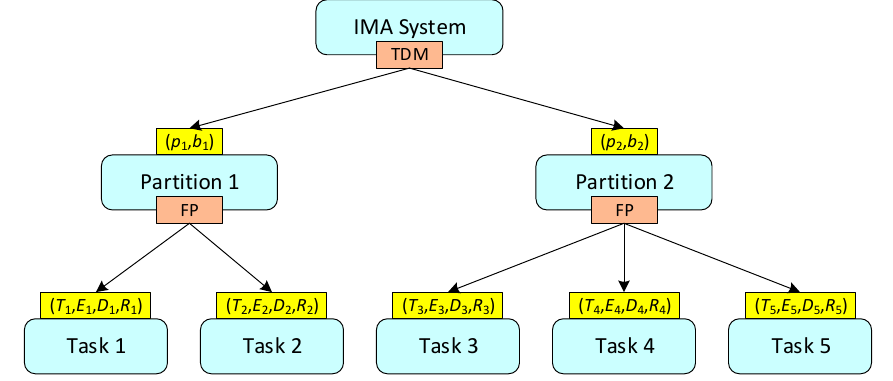
Figure 1. An example of partition scheduling systems of integrated modular avionics